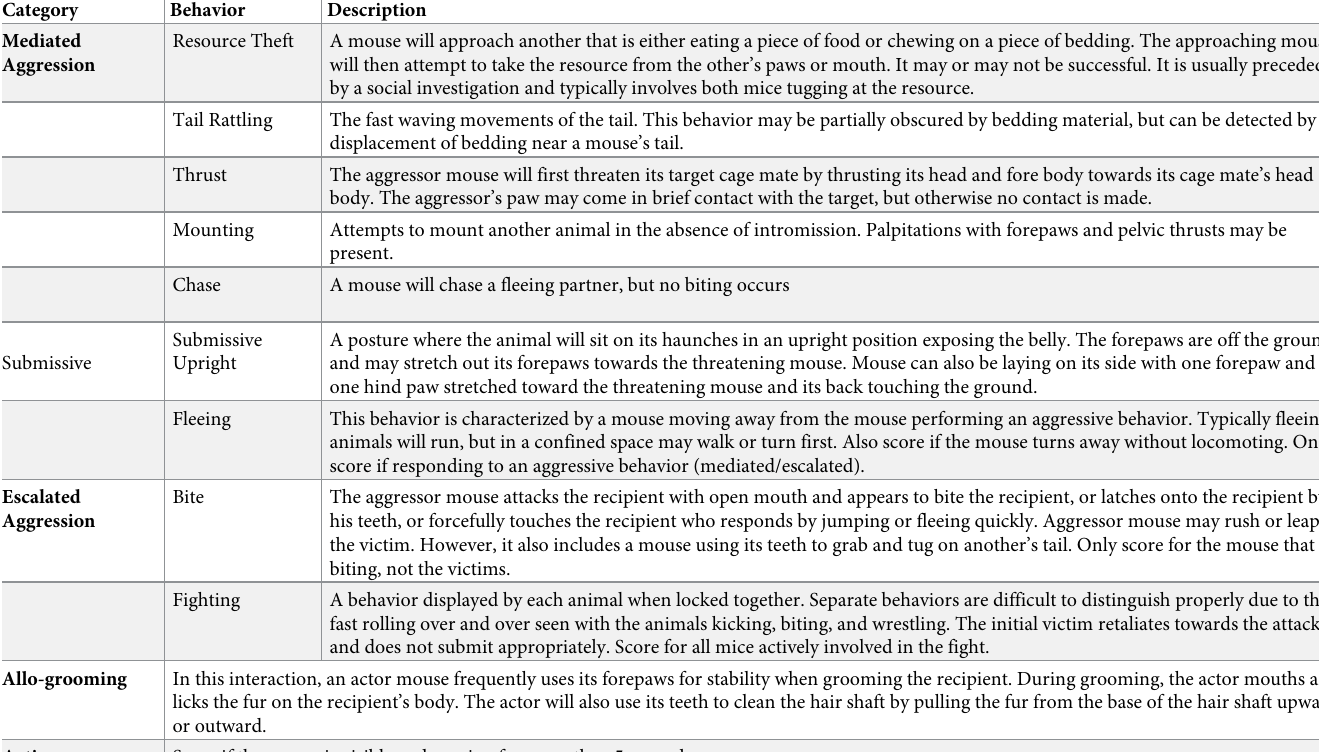
Table 2. Ethogram of behaviors observed during the study. Definitions were taken from